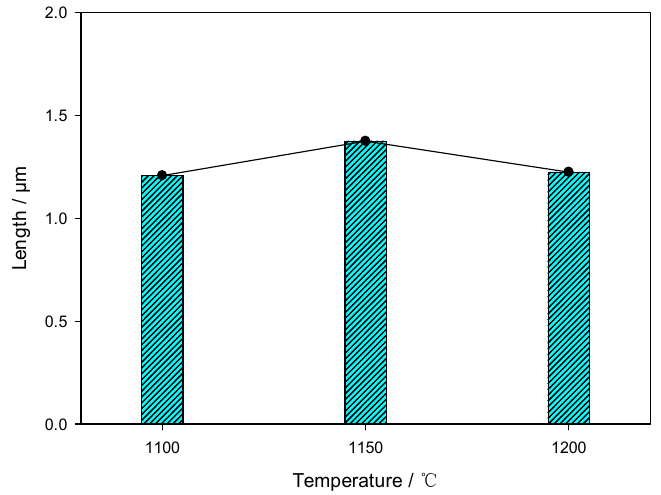
Figure 5. The thickness of Cu–steel transition layer under different hot-dipping temperatures. Due to the severe impact of cooling water and the extrusion deformation of the fan section roller in the secondary cooling zone, if the bonding strength of the ultra-thin copper/steel transition layer is not high, the two will be stripped under the action of water scouring and mechanical extrusion in the secondary cooling zone. If the copper and steel are separated, copper-induced cracks will not occur due to mold friction. Therefore, the bonding strength of the copper–steel transition layer of the hot-dip coating sample was tested in this study. In the strength test experiment, the electronic tensile testing machine was used to bond the polished copper layer and the steel matrix layer on the steel bar of the tensile sample with strong adhesive. In this study, the samples with the thinnest transition layer after hot dipping at 1100 °C for 60 s were selected for detection, and the specific results are shown in Figure 6.